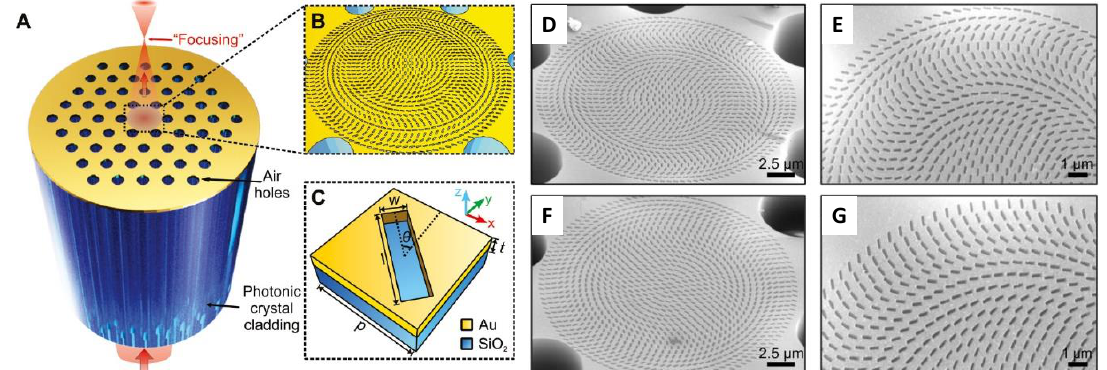
Figure 8. ( A , B ) Schematics of in-fiber metalens on photonic crystal fiber (PCF) and ( C ) unit element of PCF metalens. SEM images of fabricated PCF metalens for numerical apertures of ( D , E ) 0.37 and ( F , G ) 0.23. Reproduced with permission from [64]. The article is licensed under a Creative Commons Attribution 4.0 International License: http: // creativecommons.org / licenses / by / 4.0 / . Sensors 2020 , 20 , x FOR PEER REVIEW